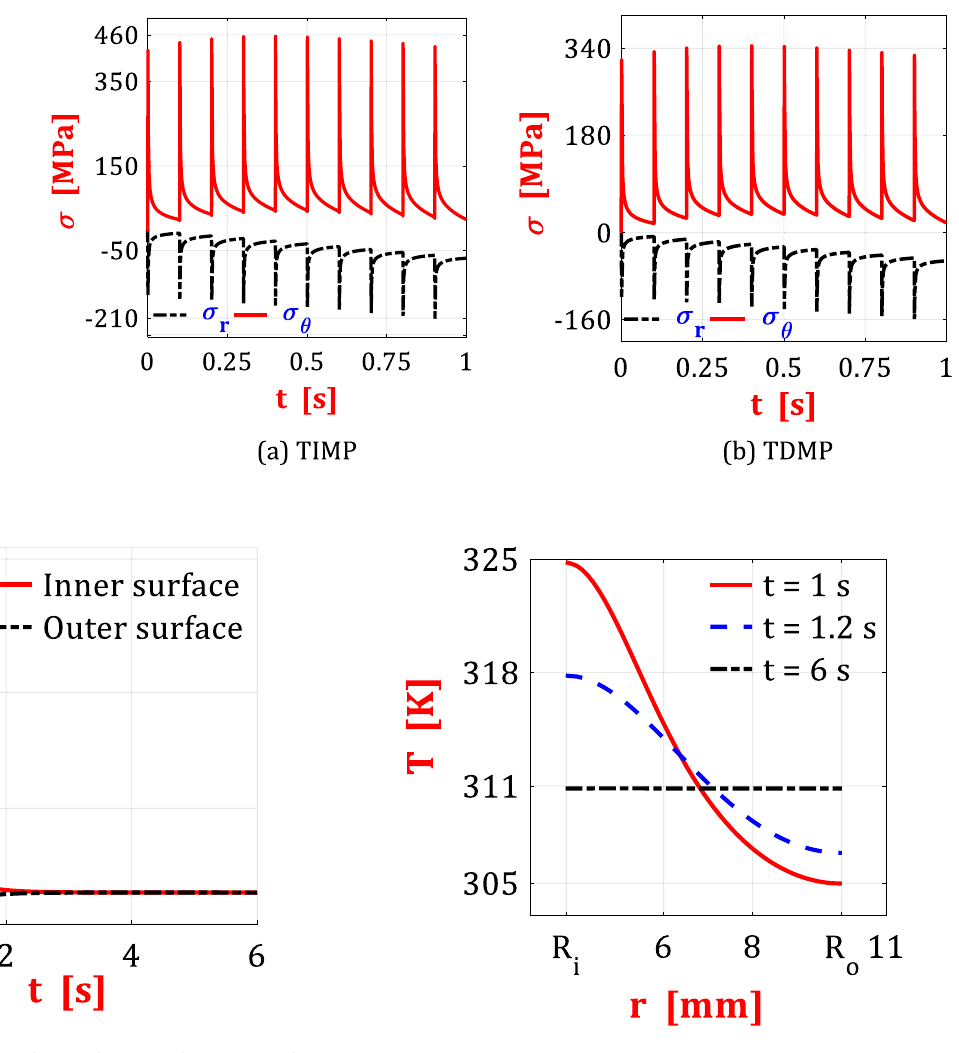
Fig. 14 The temperature variation during the 10 cycles in 6 s under the hypothesis of TDMP Fig. 15 The temperature profile through the cylinder thickness under the hypothesis of